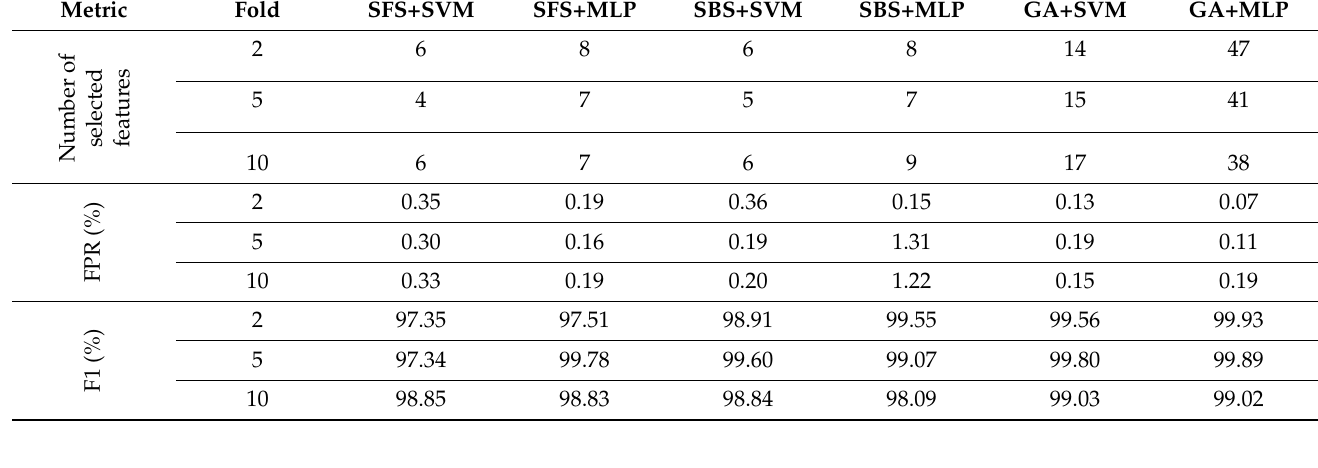
Table 11. Performance of SFS, SBS, and GA using objective function based on DR, FPR, and number Table 11. Cont. of selected features in CIC-IDS-2018.